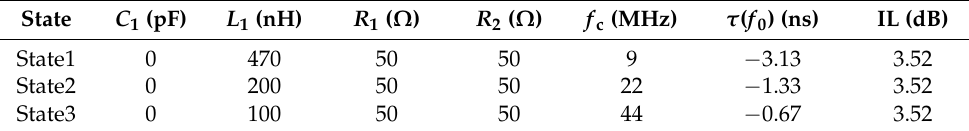
Table 5. Data of low-pass negative group delay circuits with different L 1 .